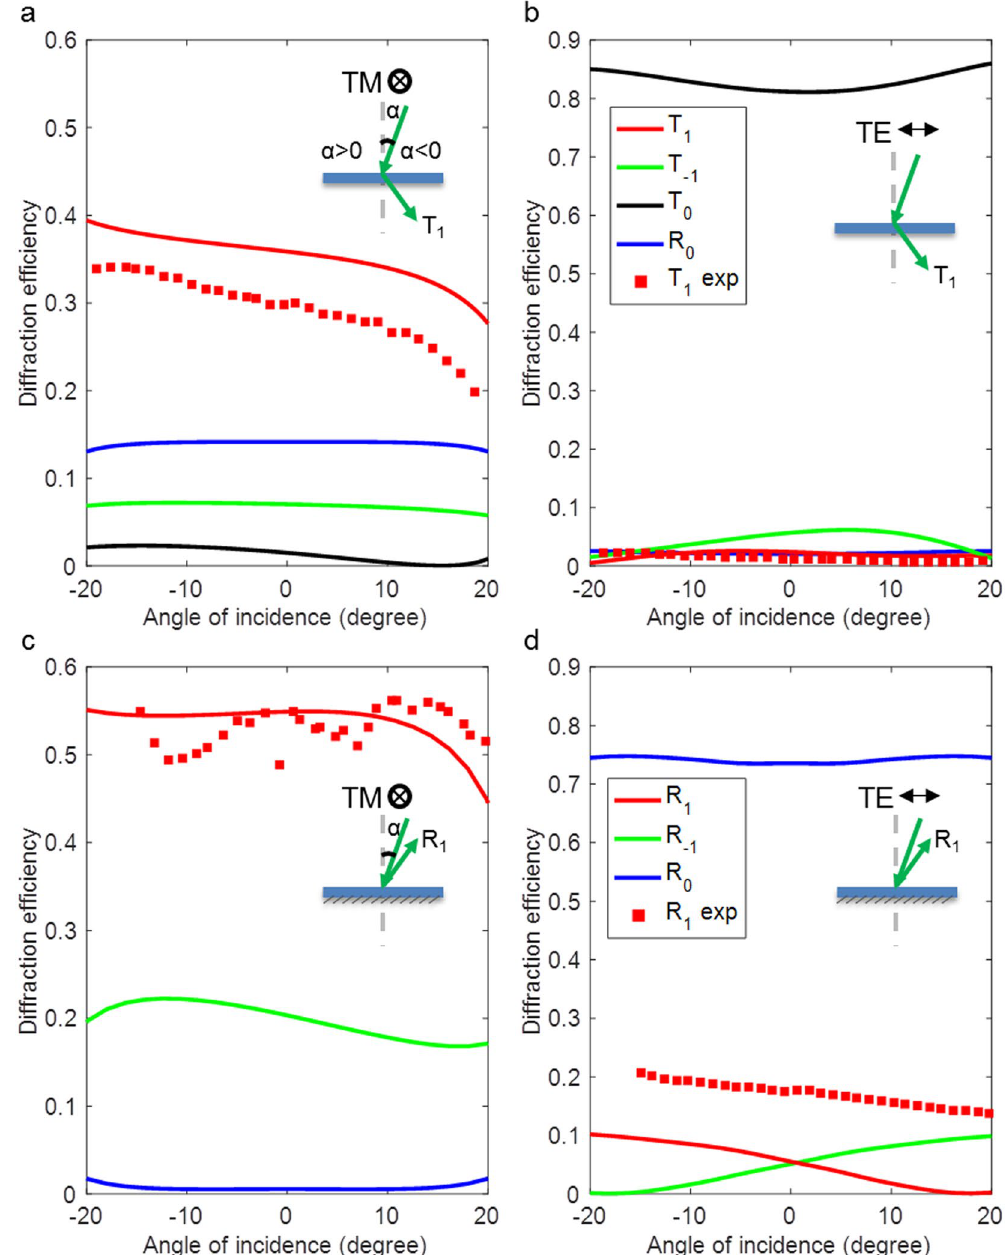
Figure 4. Transmittance and reflectance of TM and TE waves for metasurfaces working in transmission and reflection mode respectively at a wavelength of 520 nm. Diffraction efficiency versus incidence angle for transmission mode metasurfaces under illumination with ( a ) TM polarization and ( b ) TE polarization respectively. The red lines represent the theoretical (continuous line) and experimental (solid squares) diffraction efficiency of the + 1 transmitted order T 1 . The green solid line shows the diffraction efficiency of the − 1 transmitted order T- 1 . The black solid line and the blue solid line represent the zeroth-order transmittance T 0 and reflectance R 0 , respectively. Diffraction efficiency versus incidence angle for reflection mode metasurfaces under illumination with ( c ) TM polarization and ( d ) TE polarization respectively, where the red lines represent the theoretical (continuous line) and experimental (solid squares) diffraction efficiency of the + 1 reflected order R 1 . The green solid line shows the diffraction efficiency of − 1 reflected order R- 1 . The blue solid line represents the reflectance R 0 respectively. The graphs plotted on a logarithmic scale are shown in Supplementary Fig.